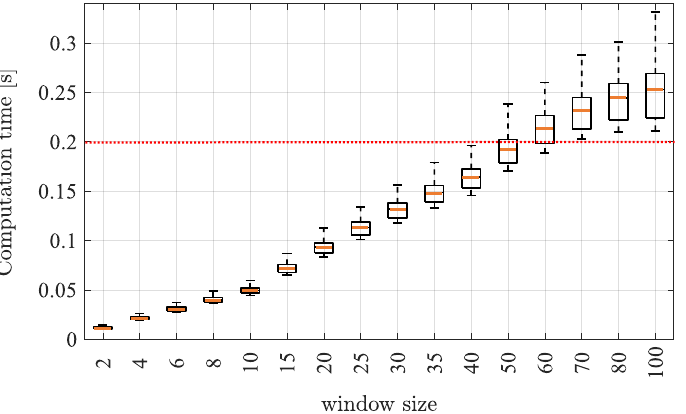
Figure 6. Computation time for different window sizes of the SEKF. The horizontal dashed line is the available sampling time.